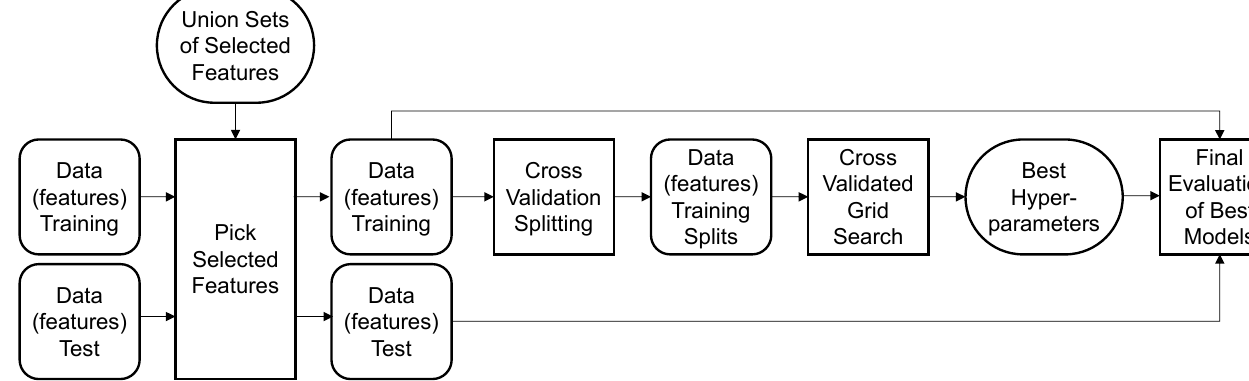
Figure 10. Procedure of cross ‐ validated grid search and final evaluation of models following the three ‐ way hold ‐ out method.